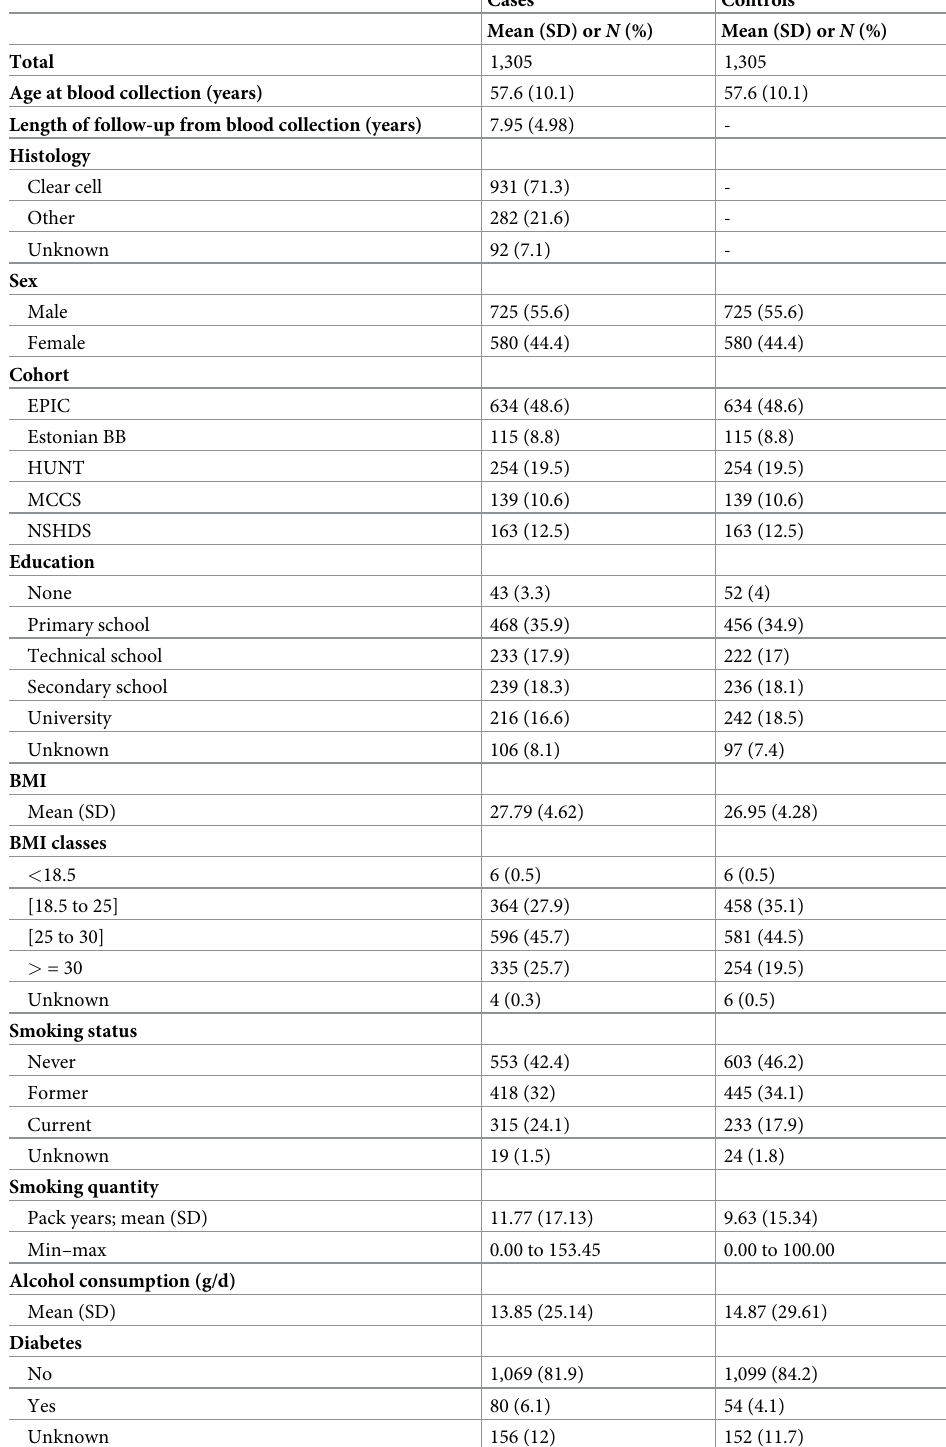
Table 1. Population characteristics of the 2,610 kidney cancer cases and controls from 5 independent cohorts with pre-diagnostic blood samples included in our analyses.